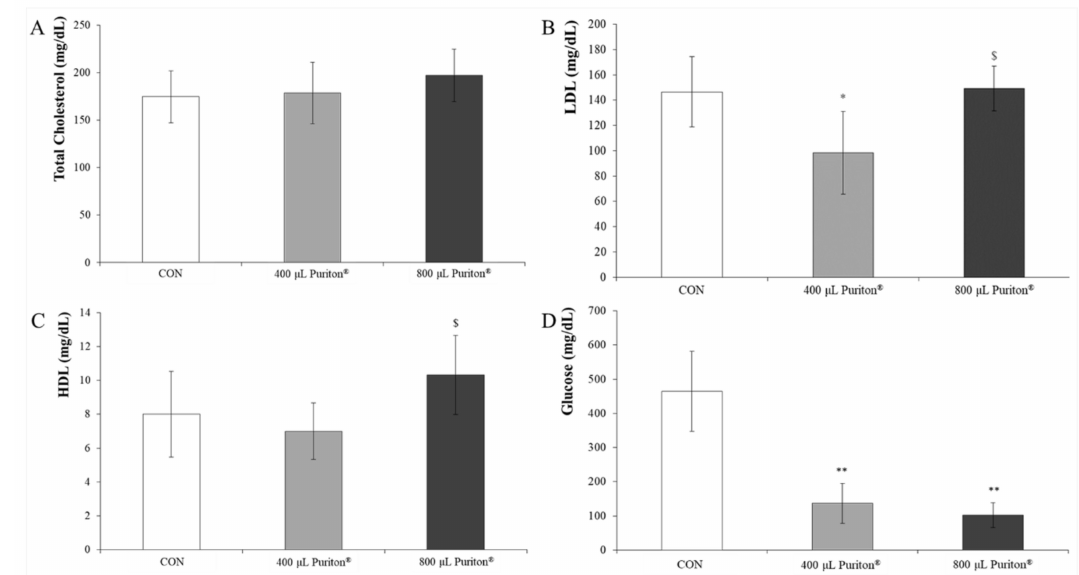
Figure 4. Results of blood chemistry analysis. Although LDL level was the highest, the HDL level was much higher than the level of other parameters. Puriton ® significantly decreased glucose levels. ( A ) Total cholesterol; ( B ) LDL; ( C ) HDL; ( D ) Glucose. LDL, low density lipid; HDL, high density lipid. Each bar represents the mean ± SD (n = 6). * p < 0.05 vs. CON group; ** p < 0.001 vs. CON group; $ p < 0.05 vs. The 400 µ L Puriton ® group.